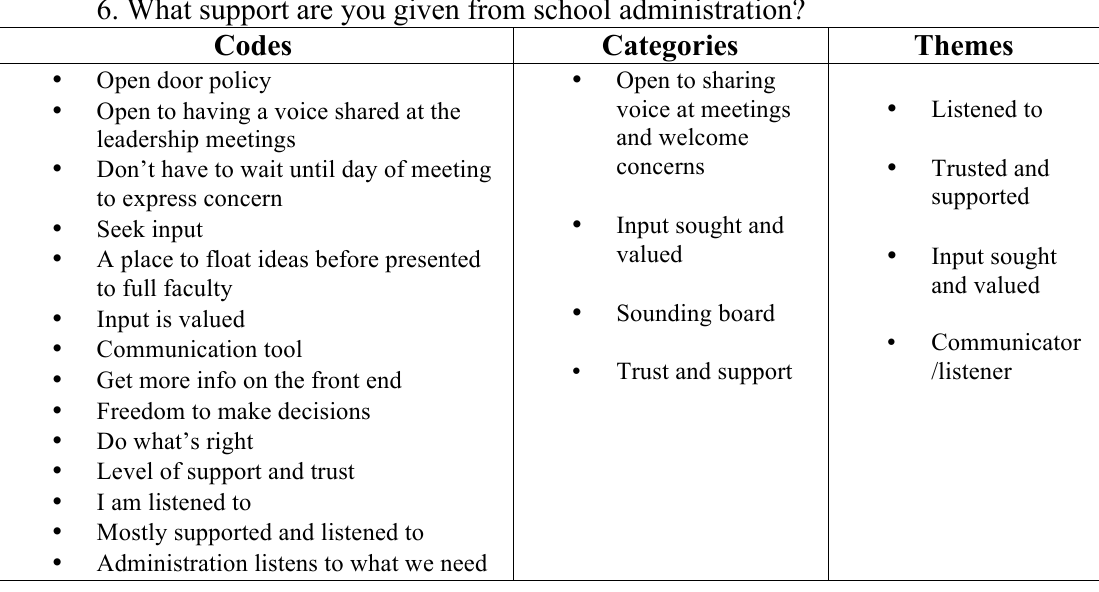
Leadership Team Members’ Question Six and